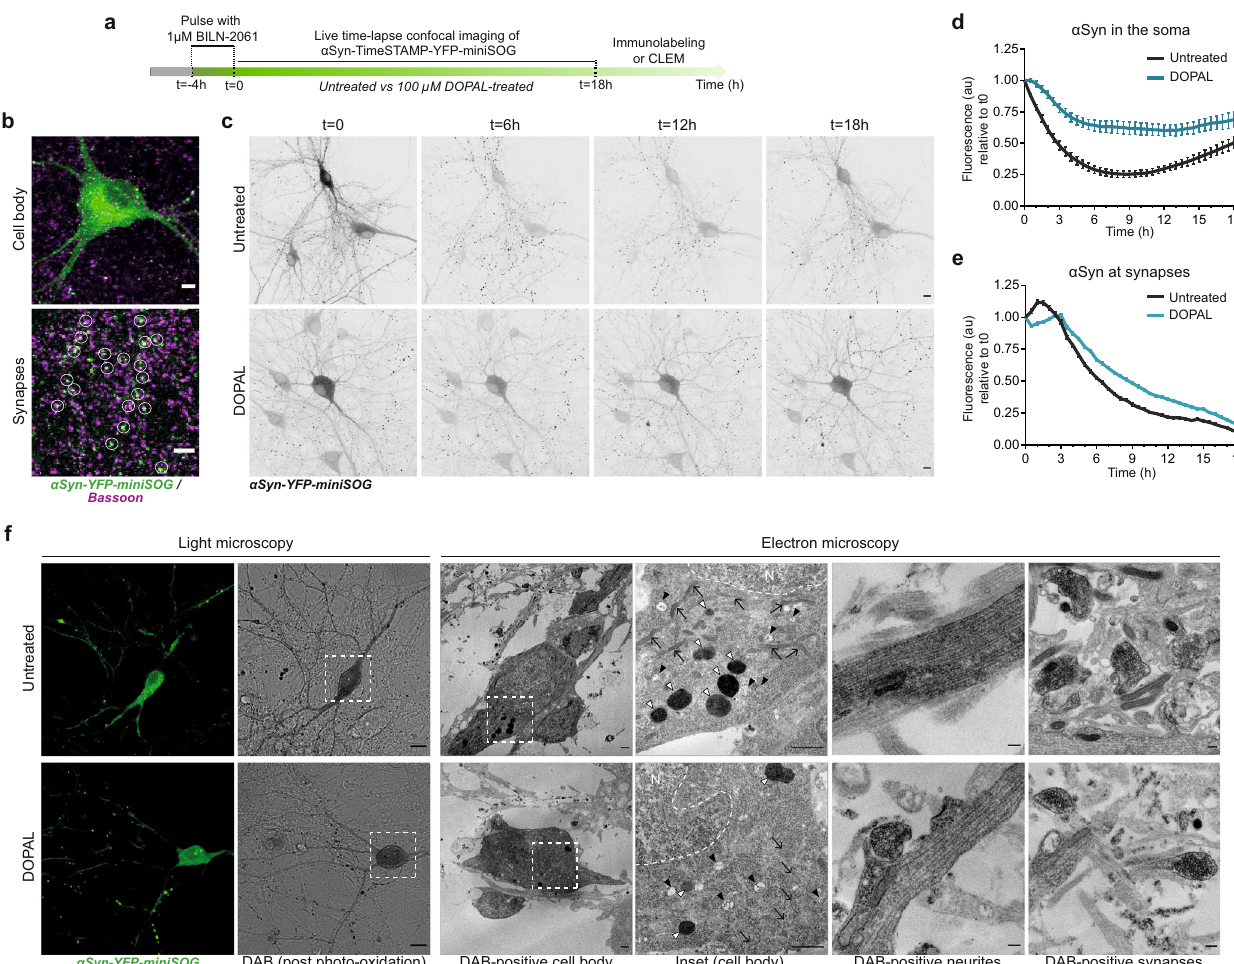
Fig. 2 DOPAL impacts α Synuclein subcellular distribution in primary rat neurons. a Schematic representation of the experimental setup of the pulse-chase experiment in α Syn-TimeSTAMP-YFP-miniSOG overexpressing primary rat cortical neurons. See also Fig. S3. b Illustrative immuno fl uorescence images showing the α Syn-YFP-miniSOG localization in the cell body (green, upper image) and in the peripheral synapses, where it co-localizes with the pre-synaptic marker Bassoon (magenta, bottom image, white circles). Scale bar: 5 μ m. c Snapshots at different time points of live time-lapse confocal imaging in untreated and 100 μ M DOPAL-treated neurons. Scale bar: 10 μ m. d , e Quanti fi cation of the YFP fl uorescence variations in the soma and at synapses, where the fl uorescence intensity of each cell body/ synapse is normalized to t = 0. Data are pooled together from three independent experiments (untreated: 41 cell bodies, 3320 puncta; DOPAL- treated: 38 cell bodies, 3712 puncta), shown as mean ± SEM each time-point, and analyzed by Two-way ANOVA with Bonferroni ’ s multiple comparison test: d interaction **** p < 0.0001, treatment **** p < 0.0001; e interaction **** p < 0.0001, treatment **** p < 0.0001. f CLEM of rat primary cortical neurons expressing α Syn-TimeSTAMP-YFP-miniSOG, at t = 24 h after BILN-2061 pulse. Photo-oxidation in untreated and 100 μ M DOPAL-treated neurons (scale bar: 10 μ m) and representative electron micrographs of the DAB-positive cell bodies (scale bar: 1 μ m), neurites and pre-synaptic terminals (scale bar: 200 nm). N: nucleus; arrows: mitochondria; black arrowheads: MVBs; white arrowheads: